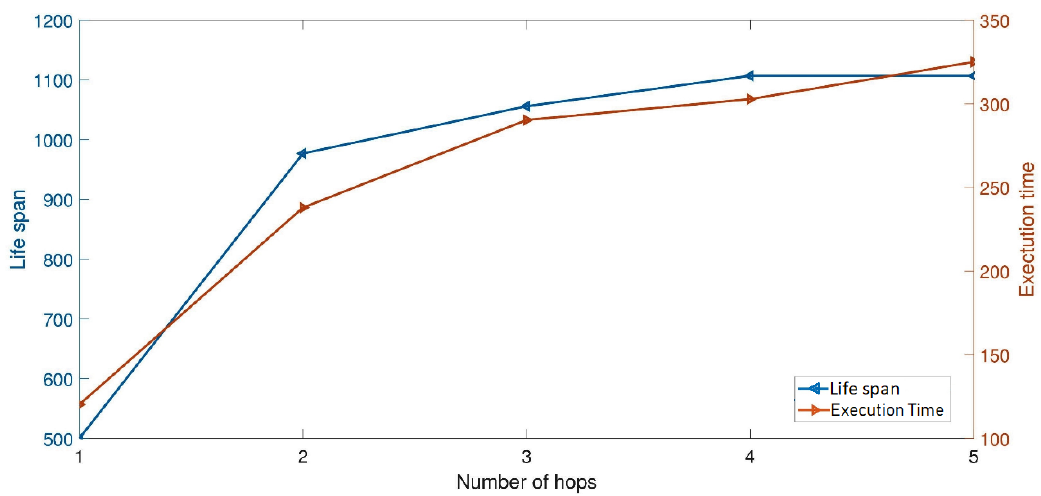
Figure 7. Life span, number of hops, and execution time.